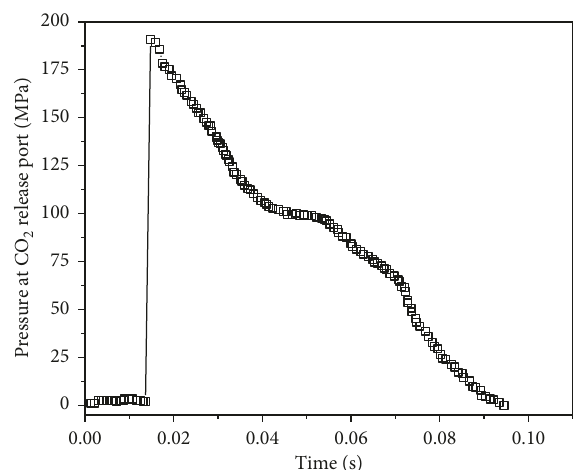
Figure 9: Change of pressure over time at the CO